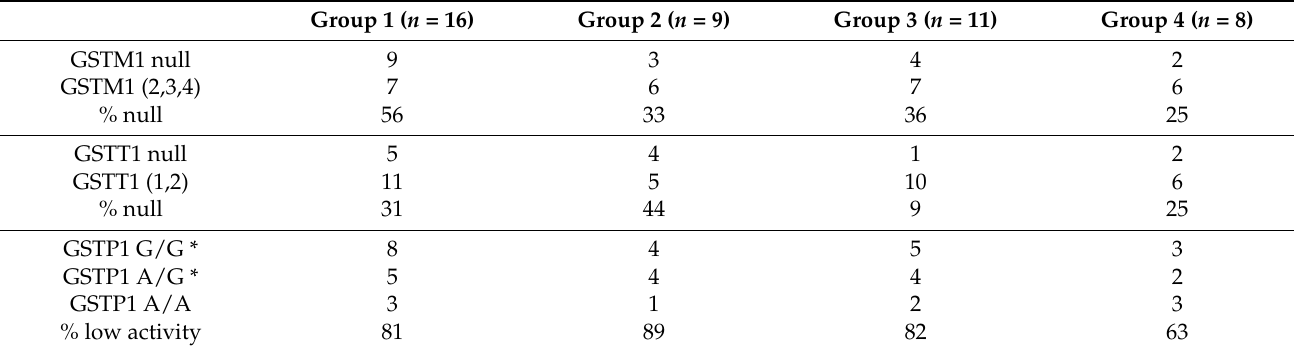
Table 2. Breakdown of GST polymorphisms for each group. GST = glutathione S-transferase. Gene families divided into